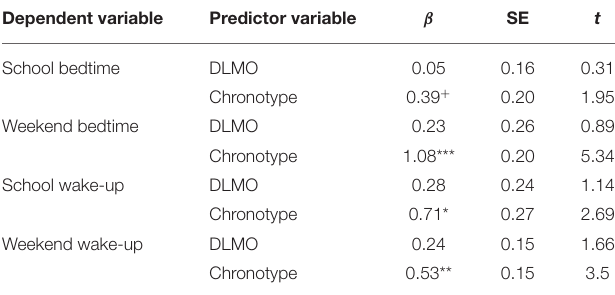
TABLE 5 | Multiple linear regression models on the predictability of DLMO and chronotype on sleep-wake times, separately for school- and weekend nights. Dependent